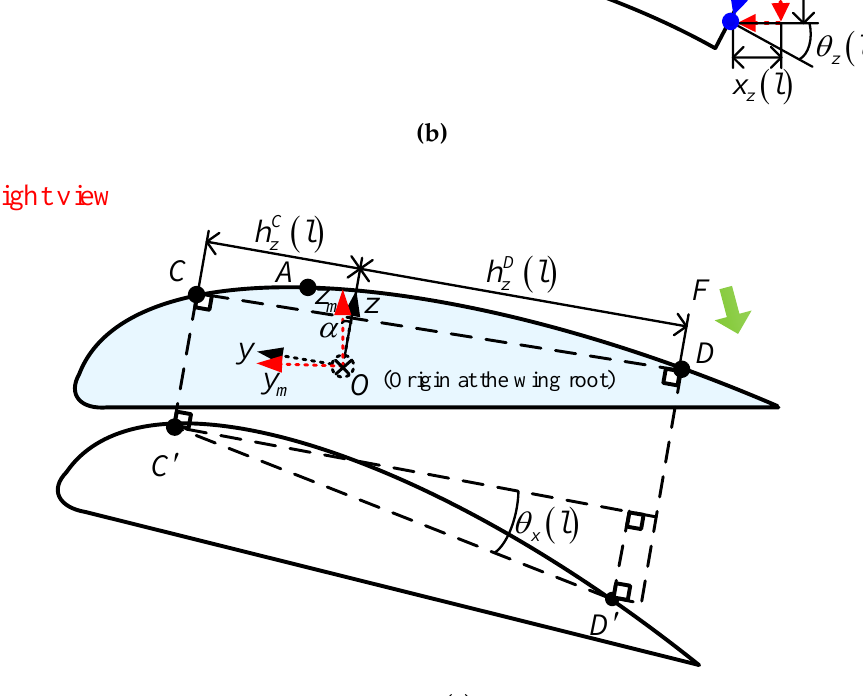
Figure 5. Bending and torsion of wing. ( a ) Bending in plane xOz ; ( b ) bending in plane xOy ; ( c ) torsion around axis x .